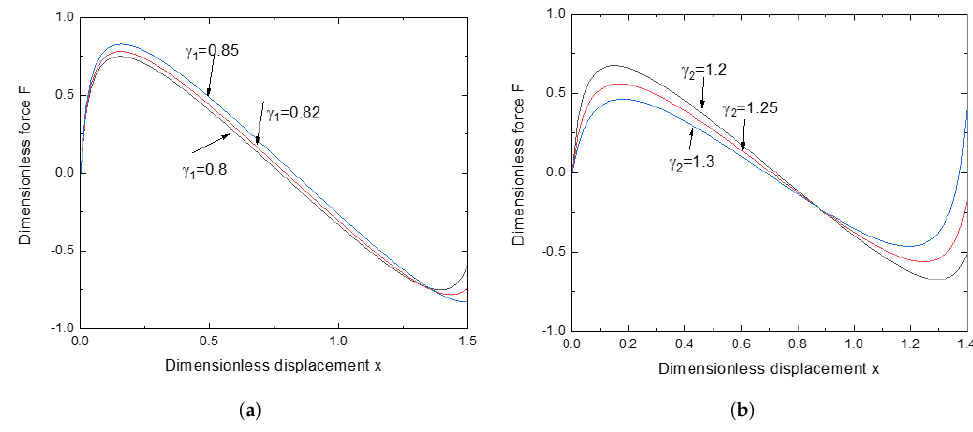
Figure 4. Dimensionless force-deflection characteristics for various configuration parameters: ( a ) for various γ 1 , ( b ) for various γ 2